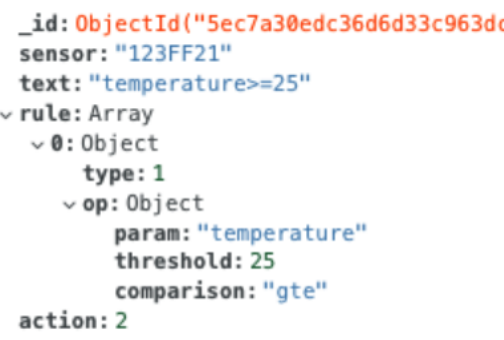
Figure 9. Rule in BSON format stored in the DB.